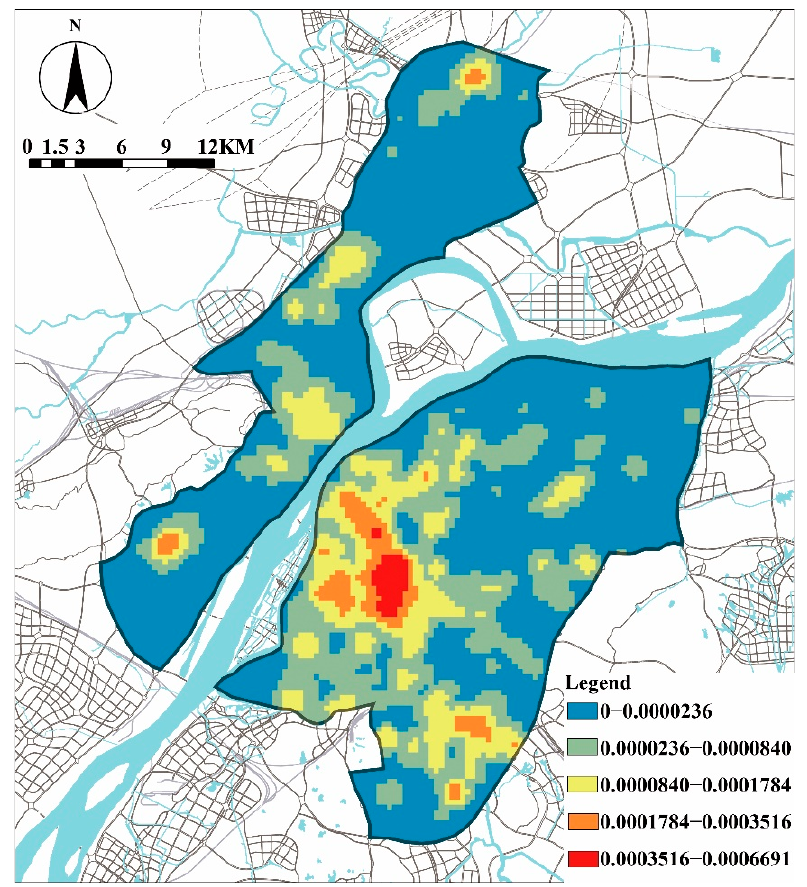
Figure 1. Density of food outlets in Nanjing.